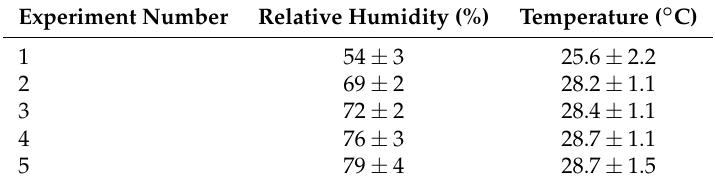
Table 2. Median Humidity and Temperature readings averaged from the four Sensirion SHT35, for each of the five experiments performed. The values are reported ± 2.5 Median Absolute Deviation